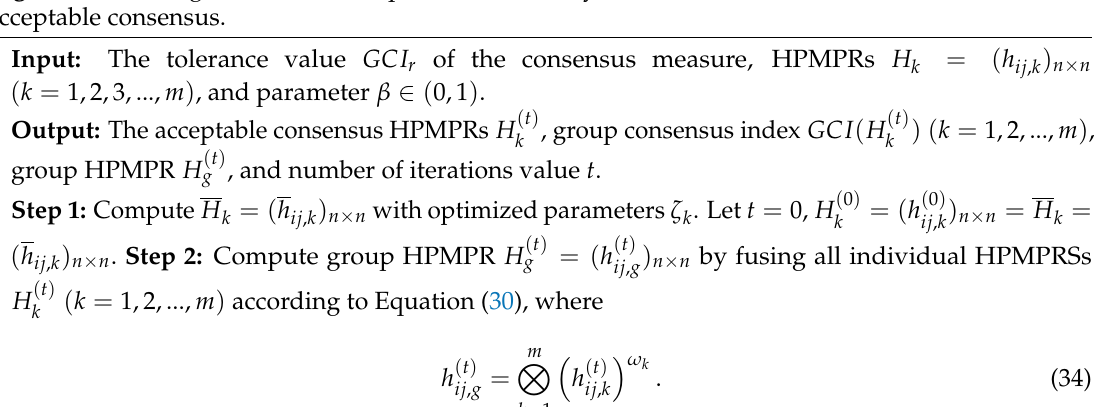
Algorithm 3 Algorithmic description to modify the dissenter’s HPMPR to reach an acceptable